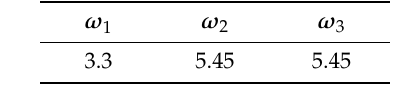
Table 5. Setting of parameters in the calculation example.